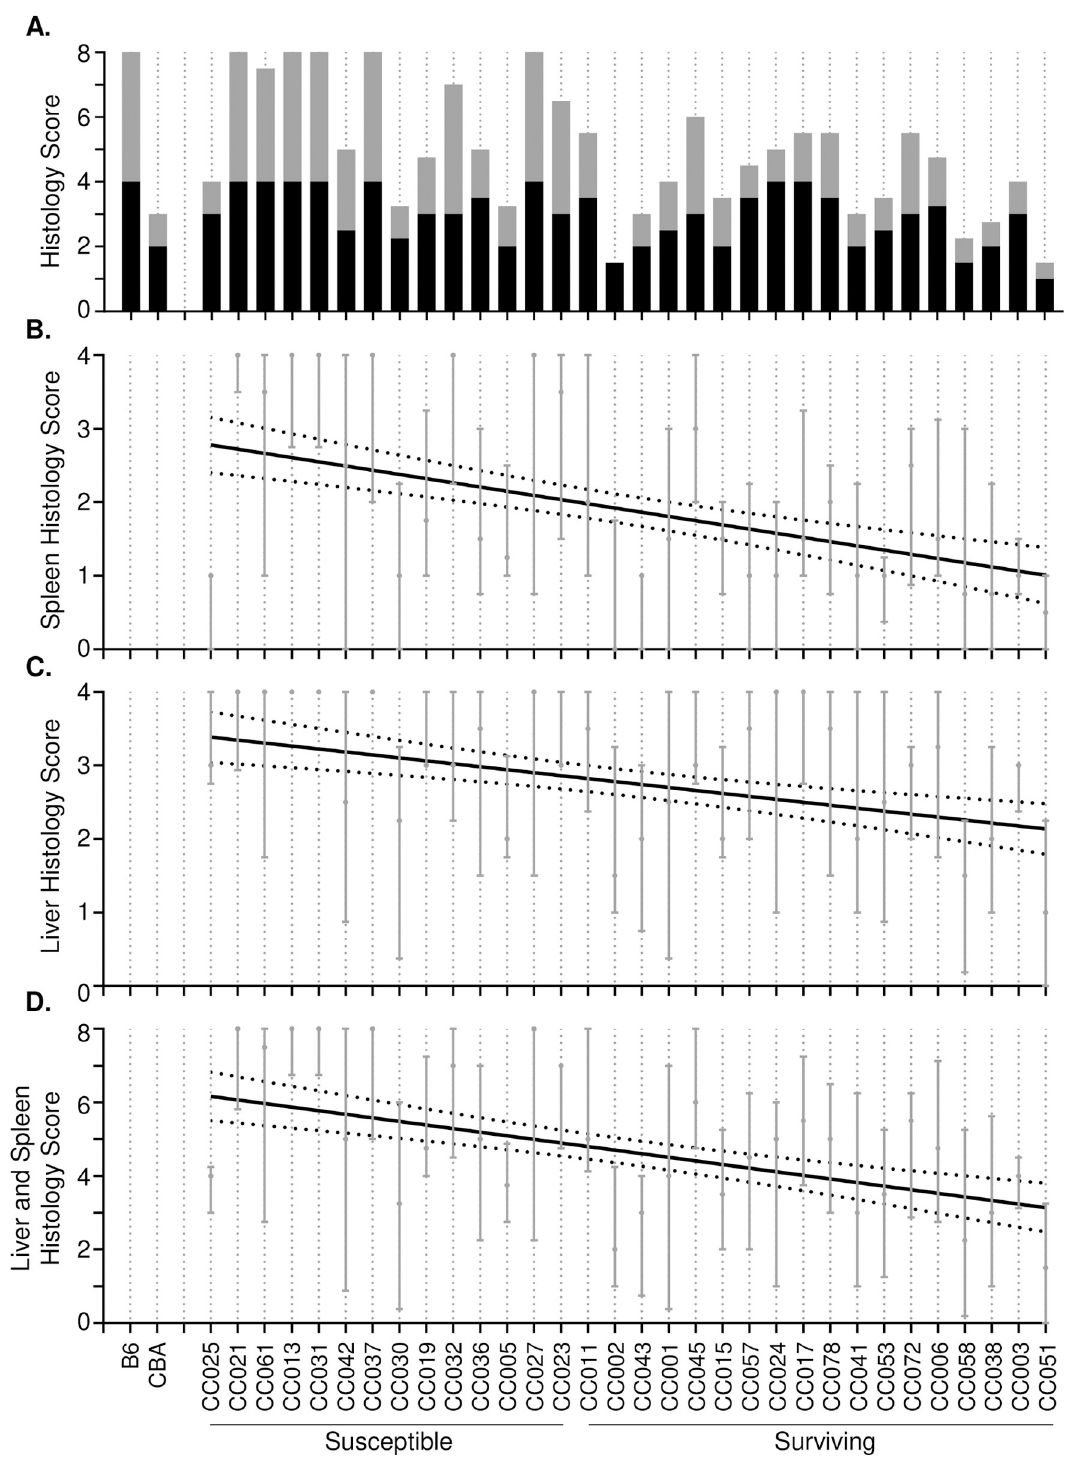
Fig 5. Spleen and liver damage correlate weakly with survival. A. Median Liver (black) and spleen (grey) histopathology scores for each strain. Scored on a scale of 0 to 4, with 0 being normal tissue and 4 being severely damaged tissue. B. Spleen (R 2 = 0.1323, P = < 0.0001) and C. liver (R 2 = 0.08382, P = < 0.0001) individual linear regression of histopathology scores. D. Linear regression of CC strains on combined spleen and liver histopathology scores (R 2 = 0.1256, P = < 0.0001). 95% confidence interval of regressions line is shown by dotted line. Medians and interquartile ranges are